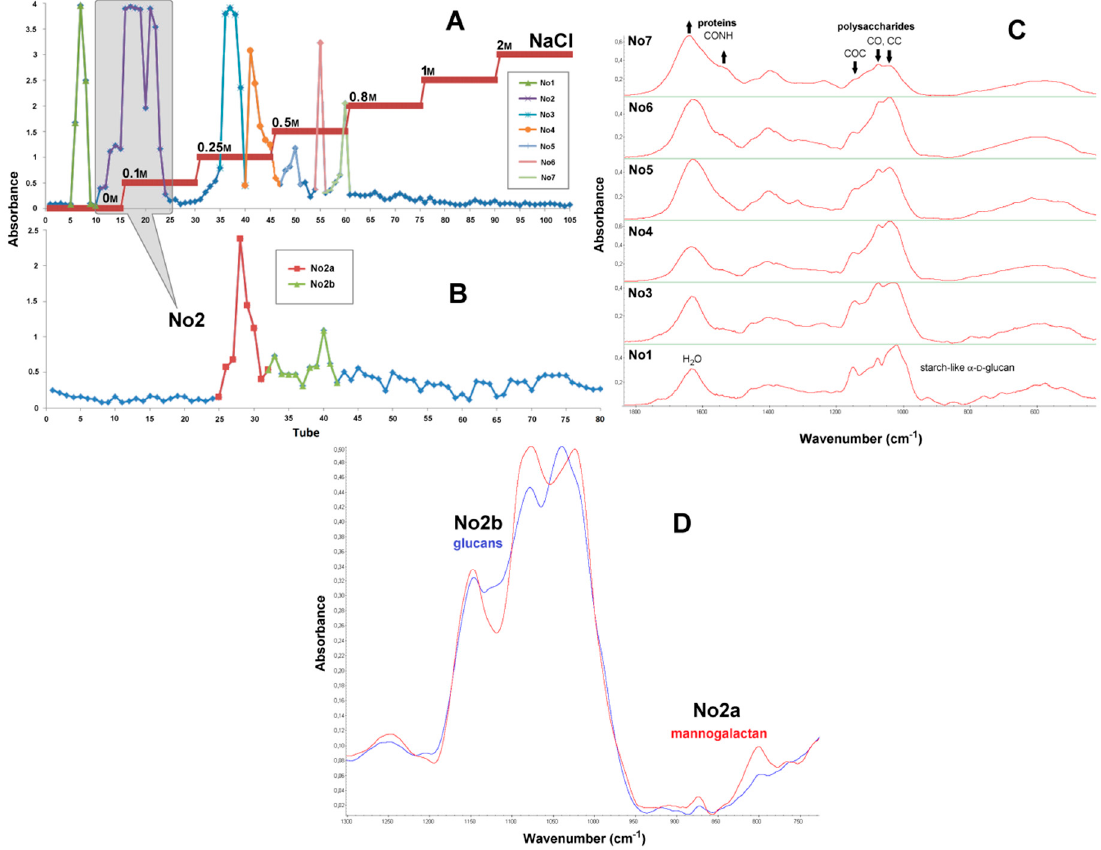
Figure 7. Chromatograms of anion exchange ( A ) and size exclusion ( B ) chromatographic separation of water-soluble polysaccharides from basidiocarps of P. ostreatus and FTIR spectra of the obtained sub-fractions ( C, D ).